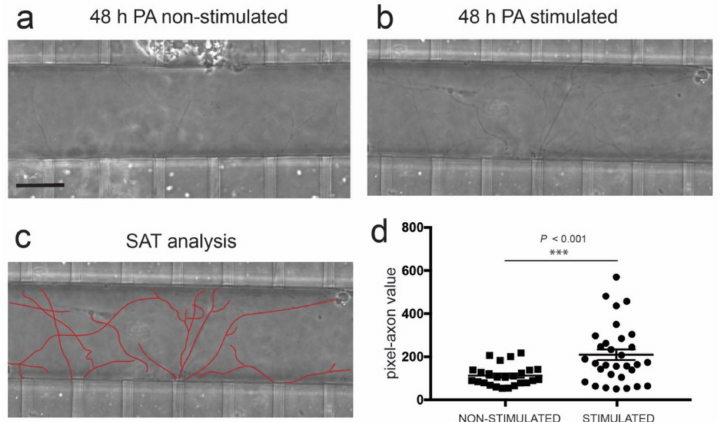
Figure 5. ( a , b ) Phase contrast images illustrating spinal cord-derived axons located in the axotomy channel 48 h after axotomy (post-axotomy (PA)) in the absence ( a ) or presence ( b ) of optical stimulation (see Material and Methods for details of the pulsatile optical stimulation) in the C2C12-ChR2 di ff erentiated myotubes. See also Supplementary Figure S4. ( c ) Example of the single axon tracing (SAT) analysis performed in the picture shown in ( b ). This analysis quantifies the number of pixels occupied by the delineated axons. ( d ) Graph illustrating the quantification of the experiments illustrated in (a–c). In the graph, each dot corresponds to the number of pixels occupied by a measured axon. The number of the devices analyzed in these experiments was 5 (stimulated) and 5 (non-stimulated). Plotted data correspond to mean ± S.E.M. The p -value of the statistical analysis is included. Scale bar: (a) = 50 µ m, pertains to